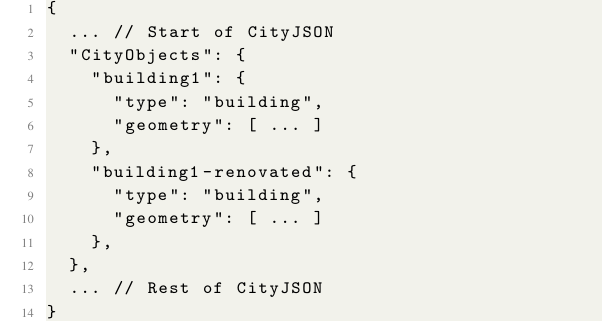
Figure 3. A suggested workflow indicating how a new